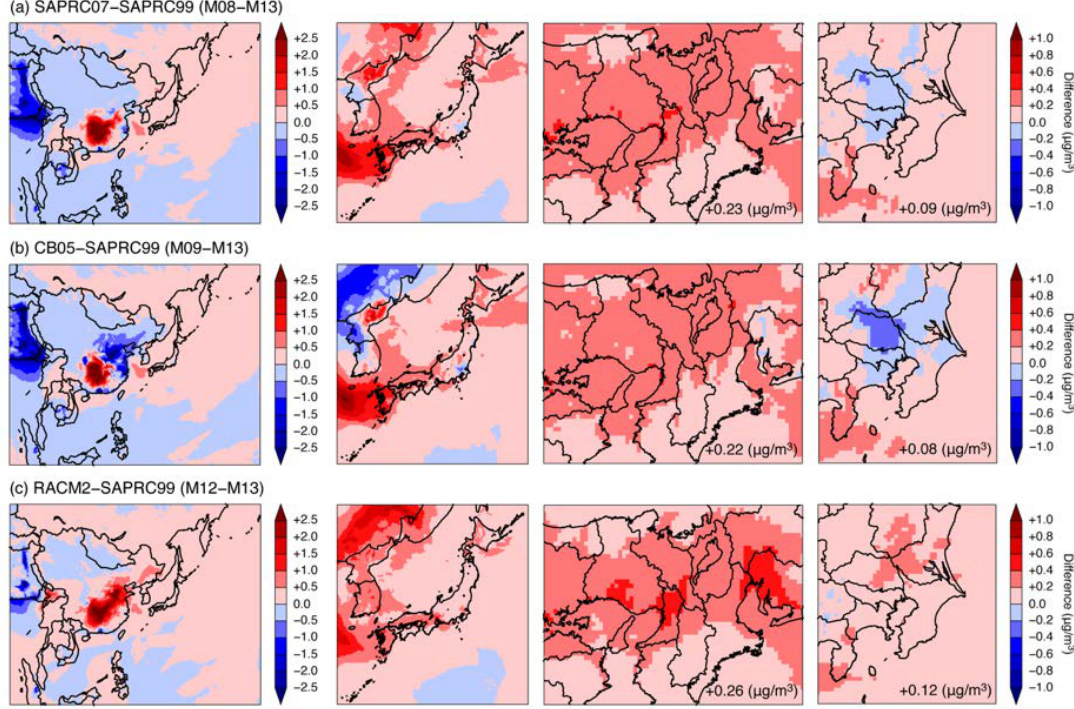
Figure 12. Spatial distributions of the difference caused by the chemical mechanism for ( a ) SAPRC07 and SAPRC99 (M08 and M13), ( b ) CB05 and SAPRC99 (M09 and M13), and ( c ) RACM2 and SAPRC99 (M12 and M13) over domains 1–4 from left to right. The value shown in the lower-right side of the panels in domains 3 and 4 indicate the spatially averaged di ff